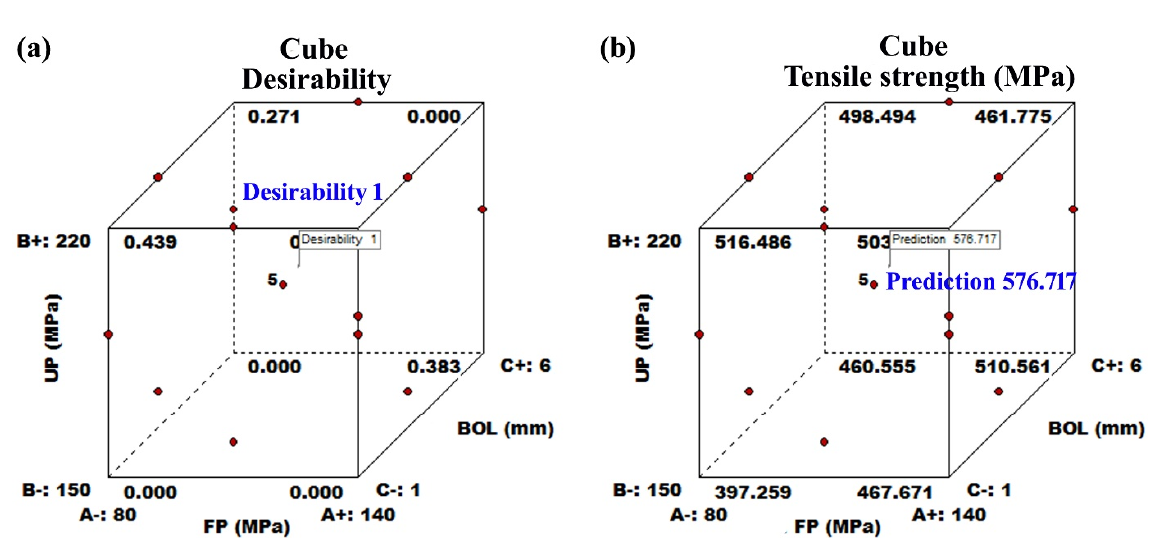
Figure 8. Mathematical distribution of the factors with cube ( a ) desirability ( b ) tensile strength.